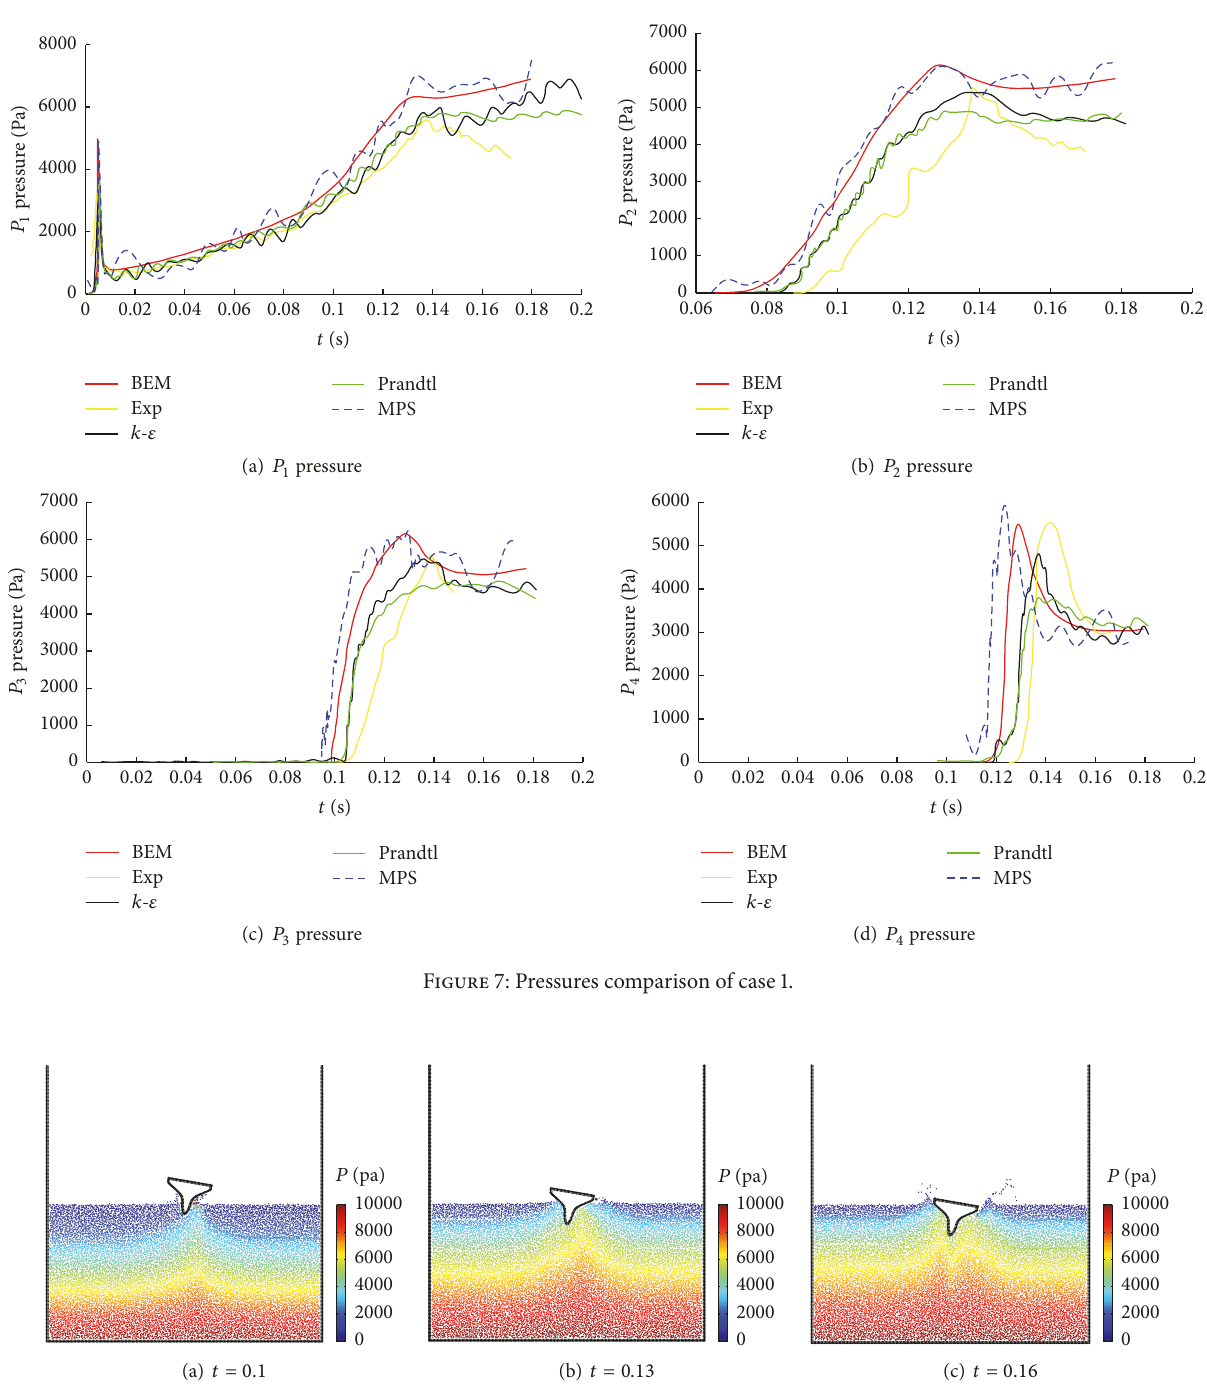
Figure 8: Particles colored by pressure after the impact with entry angle 9.8 ∘ with velocity